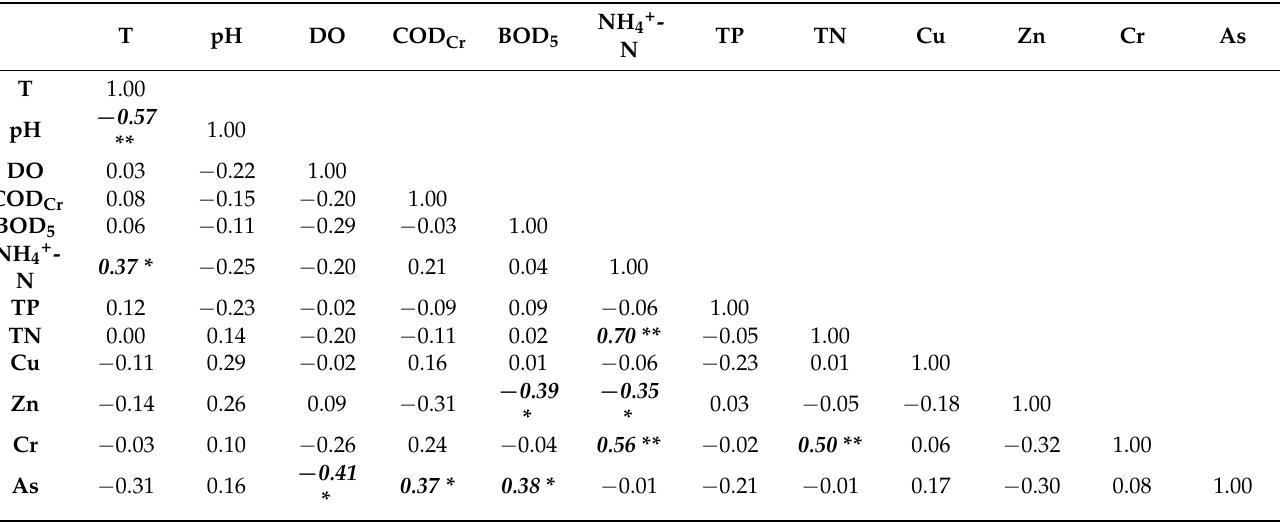
Table 5. The Spearman correlation matrix of the heavy metals and nutrients in the Xiujiang River